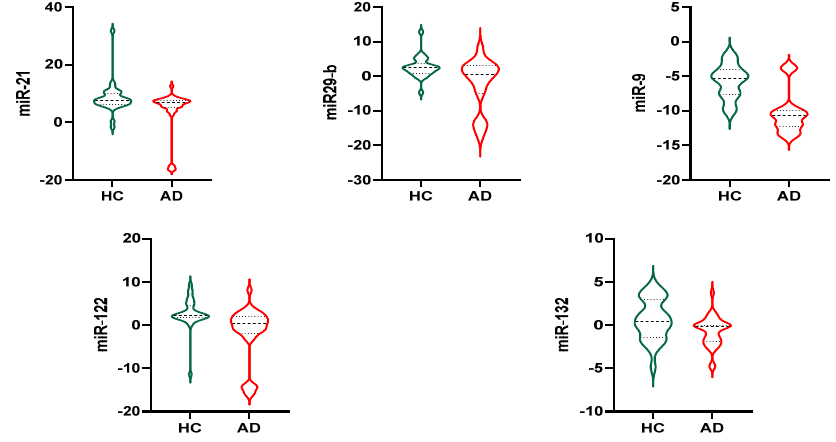
Figure 2. Exosomal miRNAs. HC: Healthy Control; AD: Alzheimer’s Disease. ‐